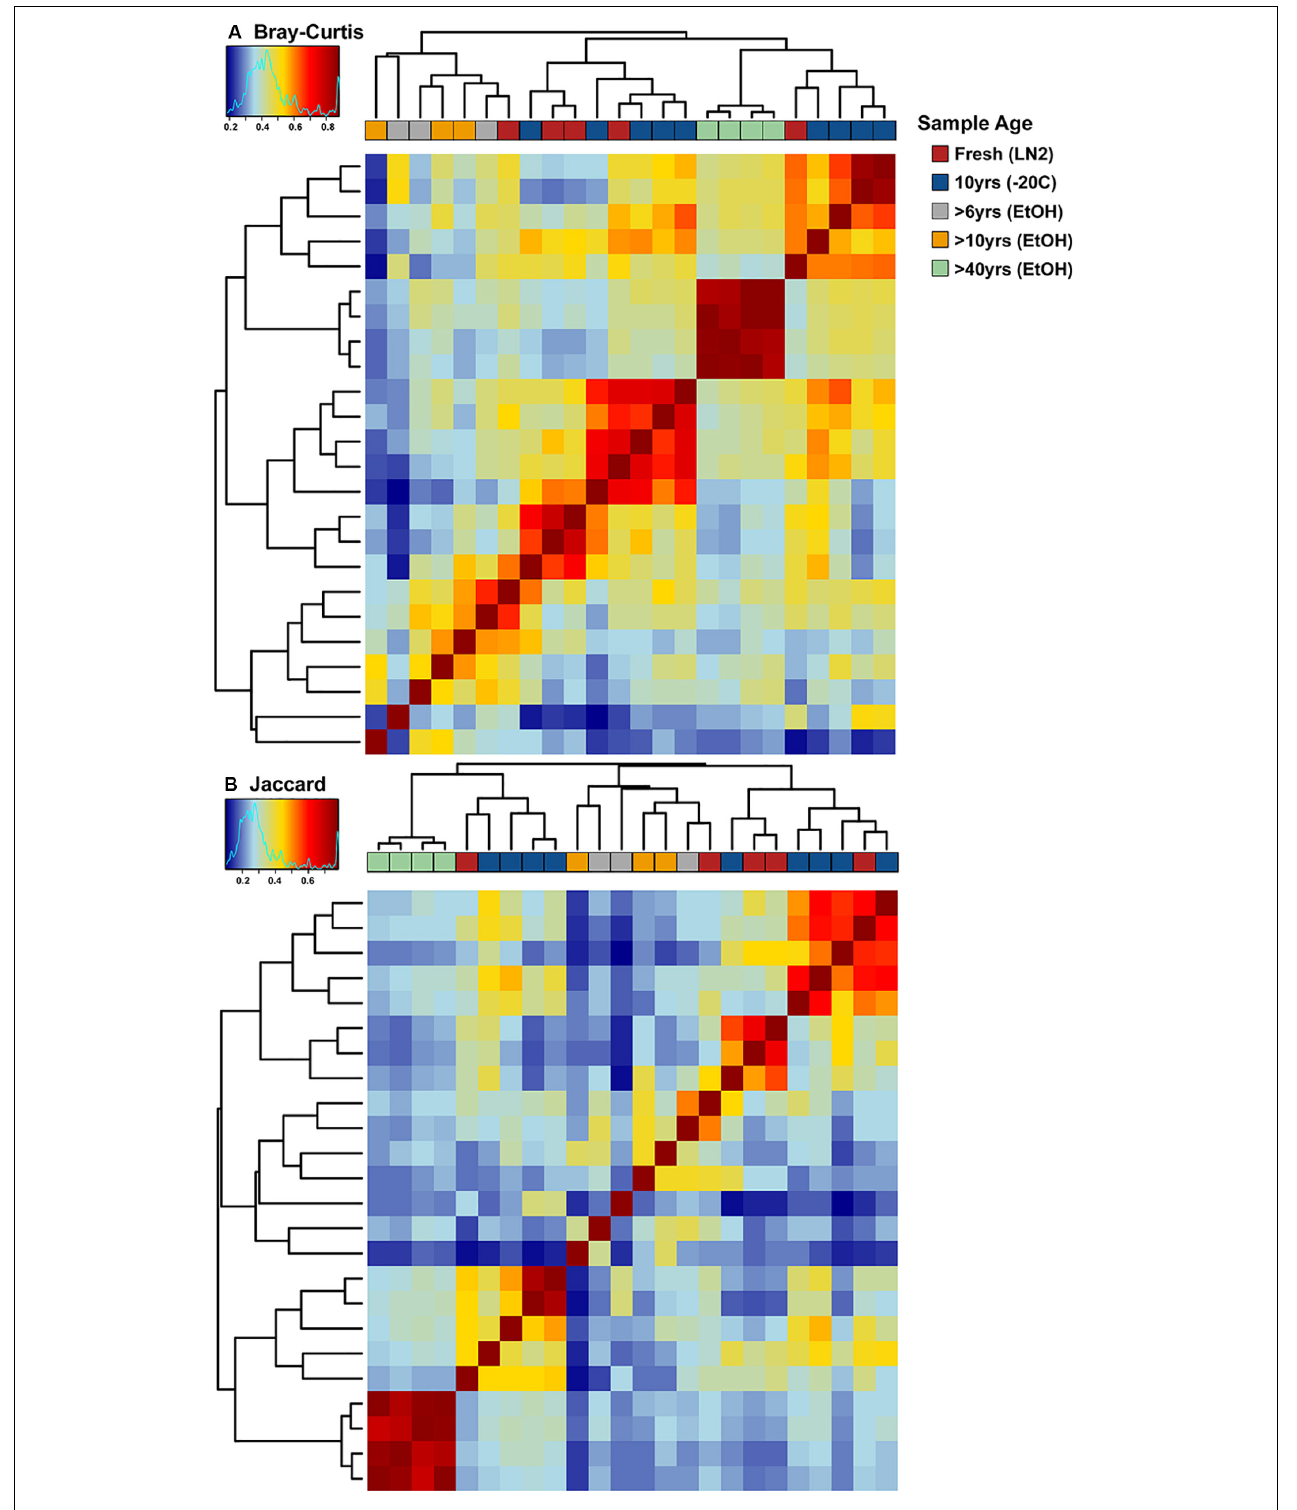
FIGURE 8 | Hierarchical clustering-based heat maps of ASV based (A) Bray-Curtis and (B) Jaccard distances depicting bacterial beta diversity of intestinal samples of varying age. Dendrograms depict relatedness of samples based on intestinal bacterial community composition at the ASV level, heat map indicates level of relatedness, where red indicates a positive correlation and blue a negative correlation.